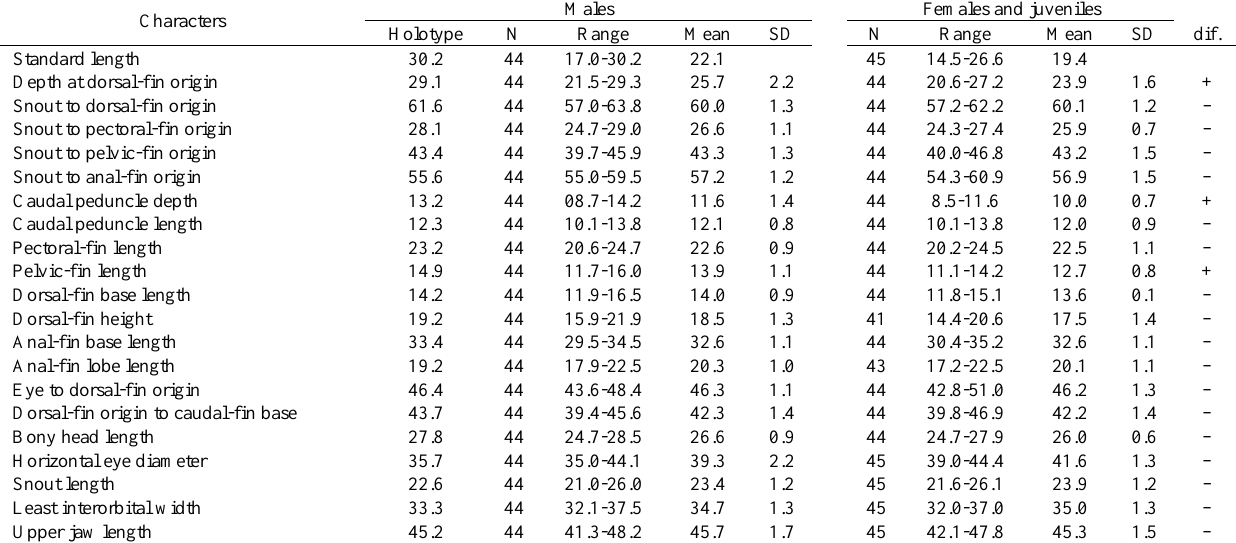
Table 10. Morphometrics of Mimagoniates sylvicola . Standard length is expressed in mm; measurements through bony head length are percentages of standard length; the last four entries are percentages head length. A plus sign under the abbreviation dif. indicates there is a significant statistical difference between the males and females in the particular character indicated. All specimens are from near Cumuruxatiba, Bahia, Brazil. MZUSP 28815, MZUSP 28816, MZUSP 28817, MZUSP 36612; USNM 276547, USNM 276556, and USNM 276557. SD = Standard deviation. Males Females and juveniles Characters